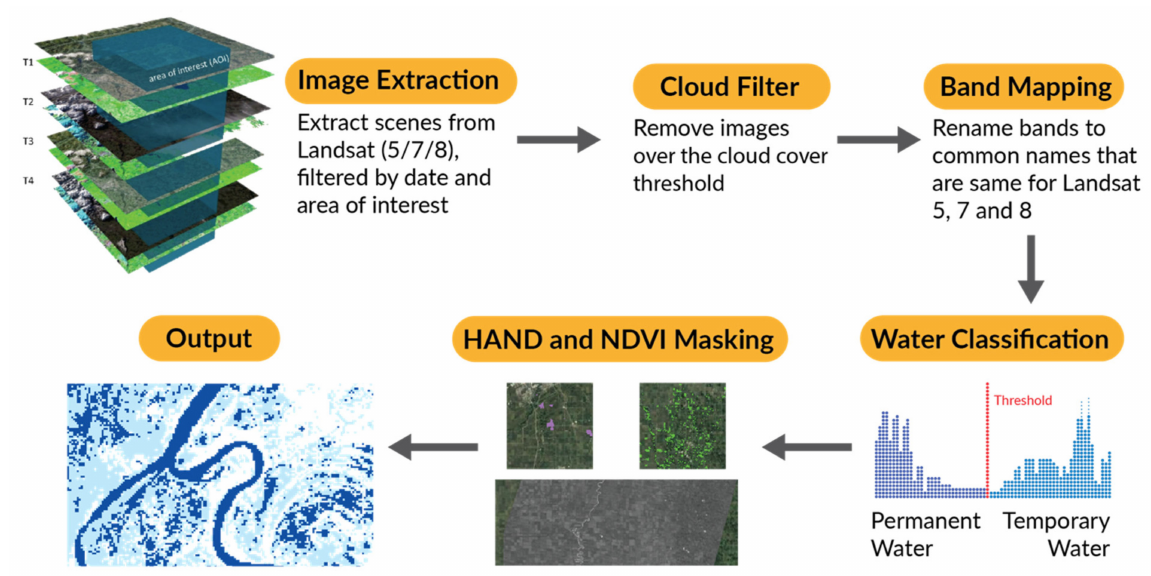
Figure 1. Schematic workflow for flood mapping in GEE using Landsat 5, 7, and